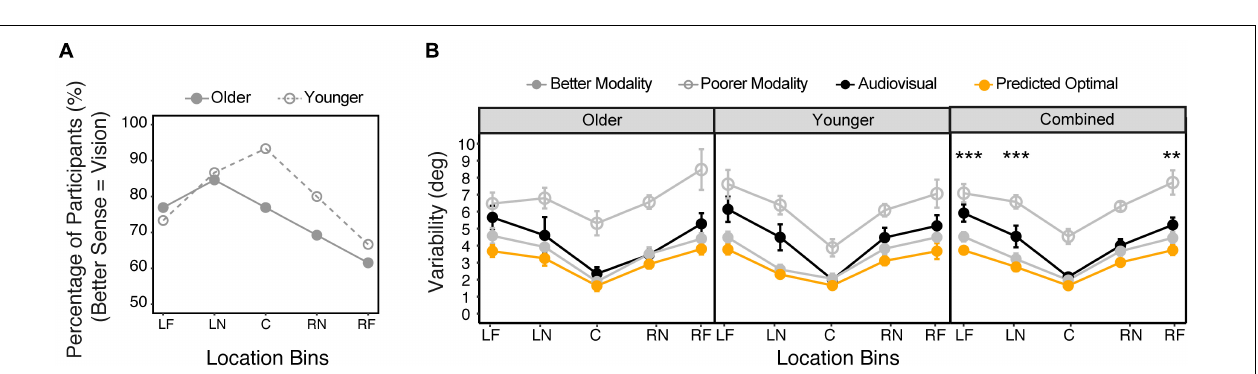
FIGURE 6 | Variability. (A) The average variability across all seventeen locations in the four conditions for the older group (left panel), younger group (middle panel), and both groups combined (right panel). (B) The average variabilities across the five bins in the four conditions for the two groups, respectively. The five bins correspond to –90 ◦ to –60 ◦ (LF), –50 ◦ to –20 ◦ (LN), –10 ◦ to 10 ◦ (C), 20 ◦ –50 ◦ (RN), 60 ◦ –90 ◦ (RF). The error bars represent standard errors. In (A) statistical asterisks represent significant difference between testing conditions. In (B) statistical asterisks represent significant difference between the two groups. *** p < 0.001; ** p < 0.05.